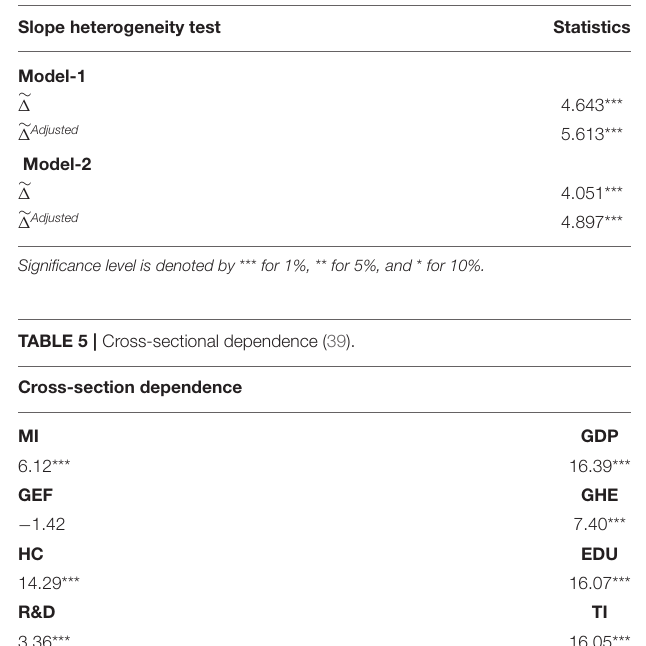
TABLE 4 | Slope heterogeneity (38).